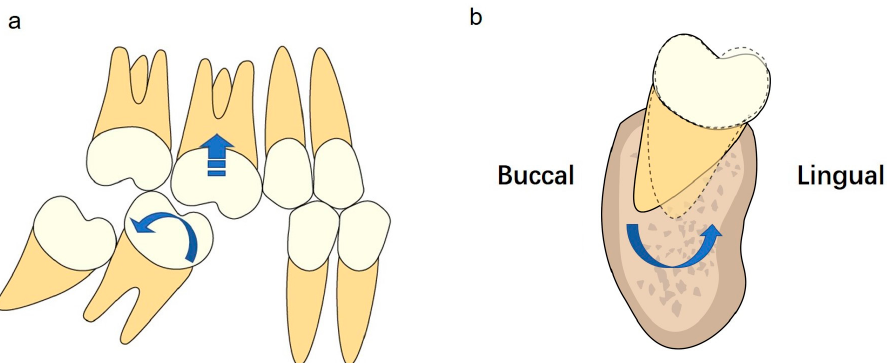
Figure 10. ( a ) Uprighting of second mandibular molars and intrusion of maxillary first molars are recommended for the protraction of mandibular second molars. ( b ) Lingual root torque of second mandibular molars is recommended for the protraction of mandibular second molars.